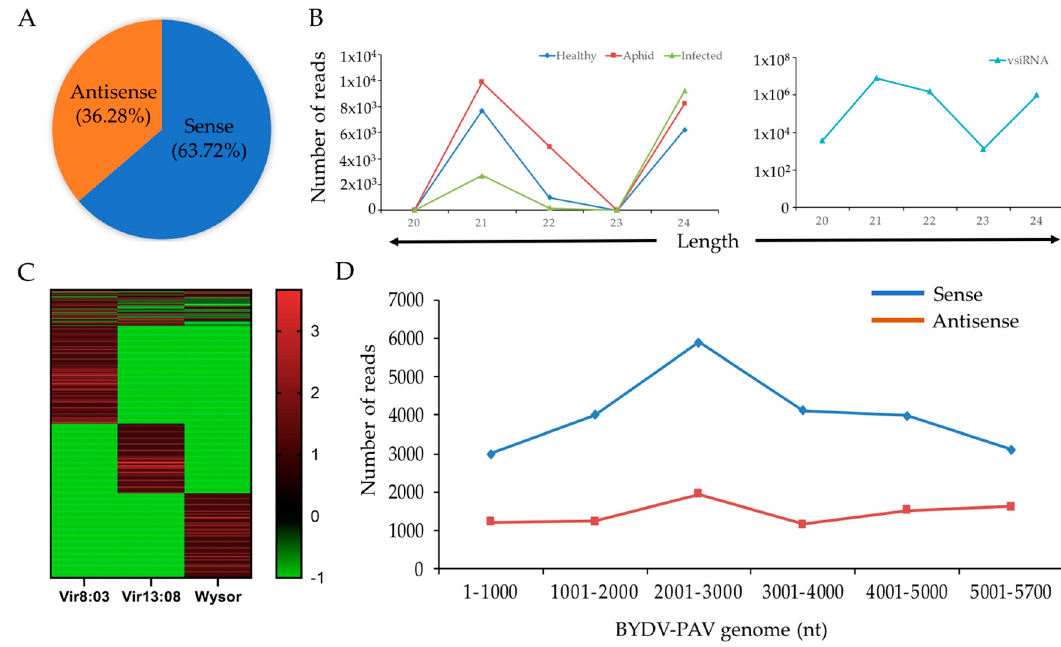
Figure 8. siRNA analysis in healthy, aphid-infested, and Barley yellow dwarf virus (BYDV)-infected barley genotypes. ( A ) Distribution of sense and antisense vsRNAs calculated as a percentage. ( B ) Length distribution of siRNAs derived from plants (upper) and the BYDV-PAV strain of Barley yellow dwarf virus (lower). X-axis: length of vsRNAs (nucleotides). Y-axis: number of reads. ( C ) Abundancy of BYDV-derived siRNAs in BYDV-infected samples of individual genotypes. Values are scaled logarithmically (value 0 is graphed as − 1). ( D ) distribution of vsRNAs on the BYDV-PAV genome. X-axis: BYDV genomic position. Y-axis: number of